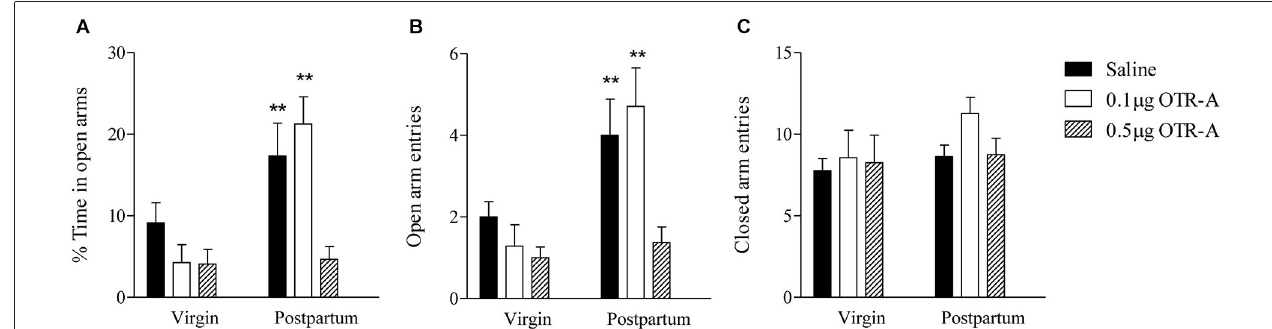
percentage of time spent in the open arms (A) and made fewer open arm entries (B) as compared to postpartum females infused with saline or low dose OTR-A. Locomotor activity, as measured by the number of closed arm entries (C) , was not altered. None of the virgin groups differed significantly from one another (A, B, C) . Bars represent mean ± SEM; ∗∗ P < 0.01 postpartum saline and postpartum 0.1 µ g/ µ l OTR-A vs. all other